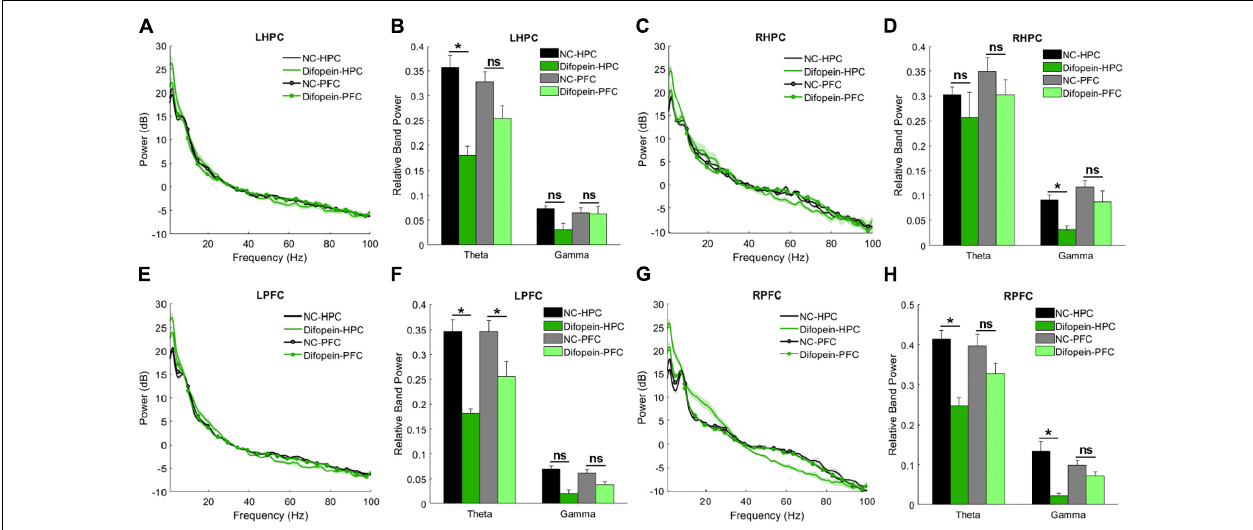
FIGURE 6 | Task-related power in WT mice injected with AAV-YFP negative control virus (NC-HPC, n = 6; NC-PFC, n = 10) and AAV-YFP-difopein (Difopein-HPC, n = 5; Difopein-PFC, n = 7). LHPC theta power (A,B) and RHPC gamma power (C,D) are significantly decreased in Difopein-HPC but not Difopein-PFC mice. LPFC theta power is significantly decreased in both Difopein-HPC and Difopein-PFC mice (E,F) . RPFC theta and gamma power is significantly decreased in Difopein-HPC but not Difopein-PFC mice (G,H) . Statistical significance denoted as * p < 0.05. ns , not significant.